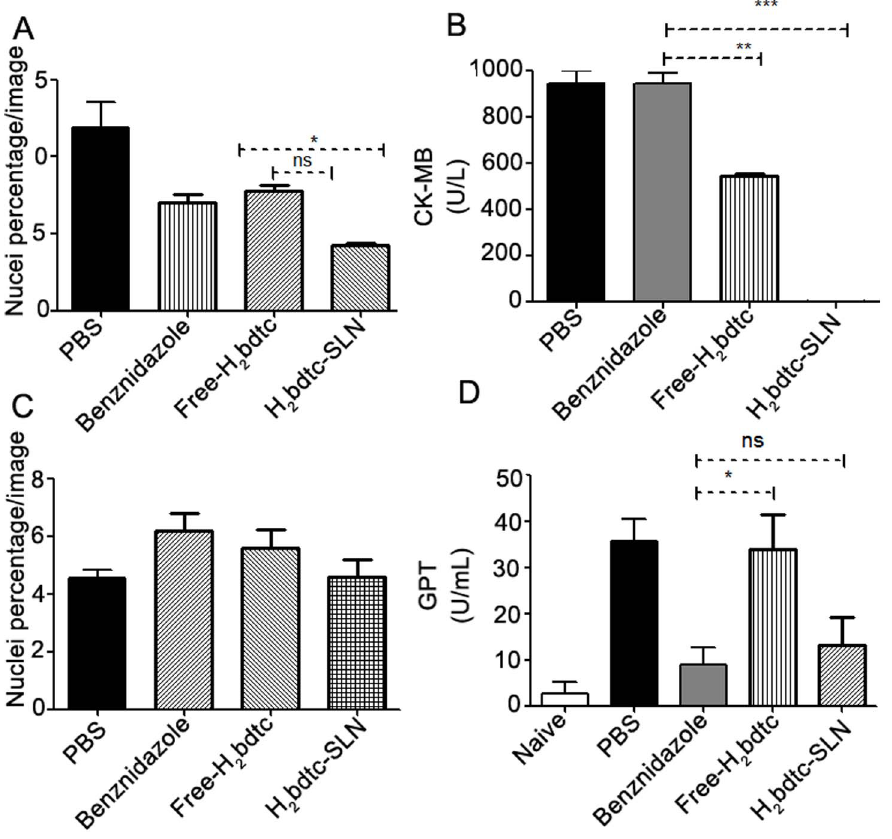
Figure 5. Cardiac and liver lesions of T. cruzi- infected animals after treatment with H2bdtc encapsulated in solid lipid nanoparticles. (A) Quantification of cellular nuclei per 50 m m2 of heart tissues derived from non-treated and treated animals. (B) Quantification of CK-MB in the serum of infected and treated mice. (C) Quantification of cellular nuclei per 50 m m 2 of liver tissues derived from non-treated and treated animals. (D) Quantification of glutamic-pyruvic transaminase (GPT) levels. The mean + statistically significant differences compared with the control are denoted by: *p , 0.05, **p , 0.01 e ***p , 0.001, T student test.